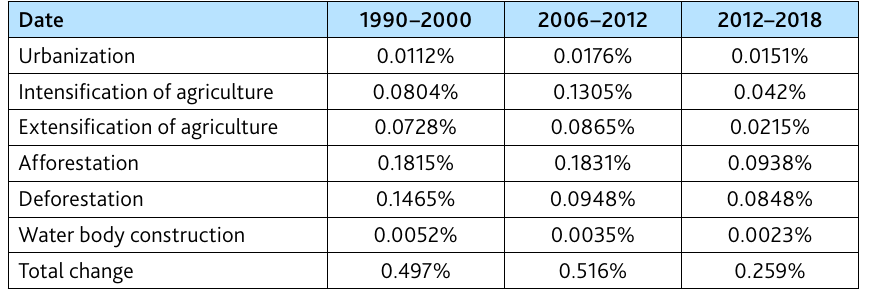
Table 1. Mean yearly categorized land use changes, based on CLC change maps